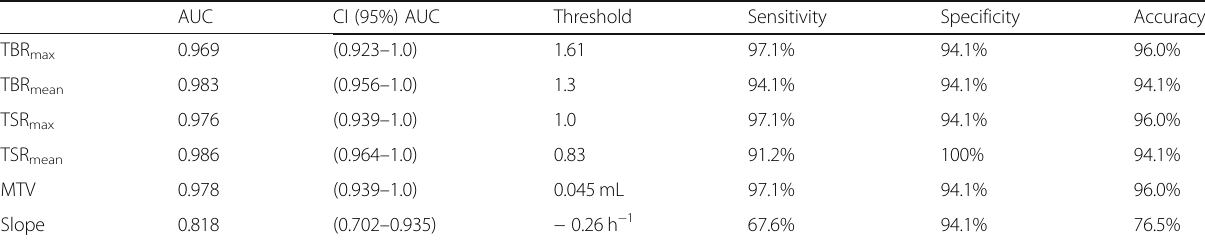
Table 3 Results provided by ROC curve analyses for the PET identification of patients with glioma recurrence or progression AUC CI (95%) AUC Threshold Sensitivity